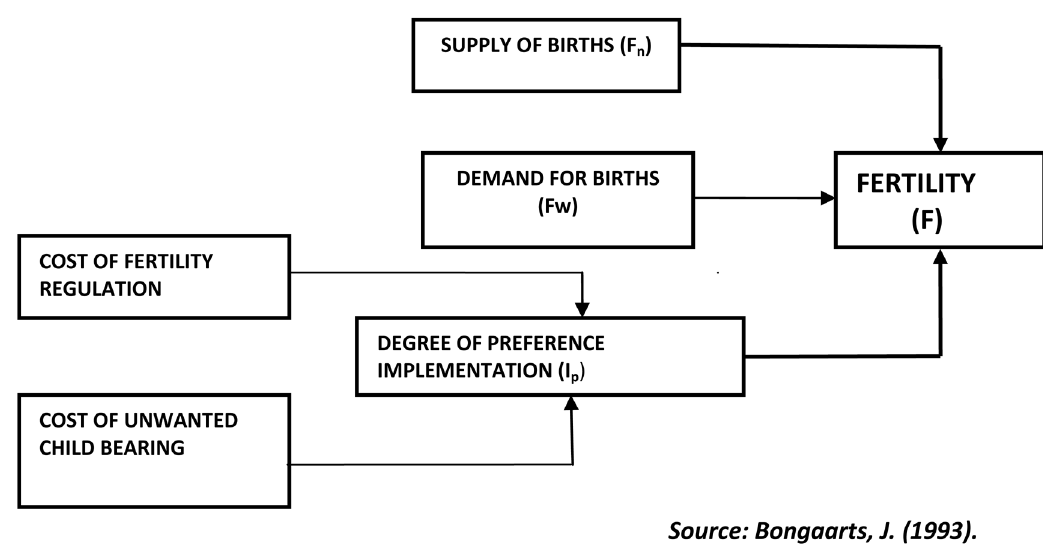
Figure 1. Variants in the supply-demand model.